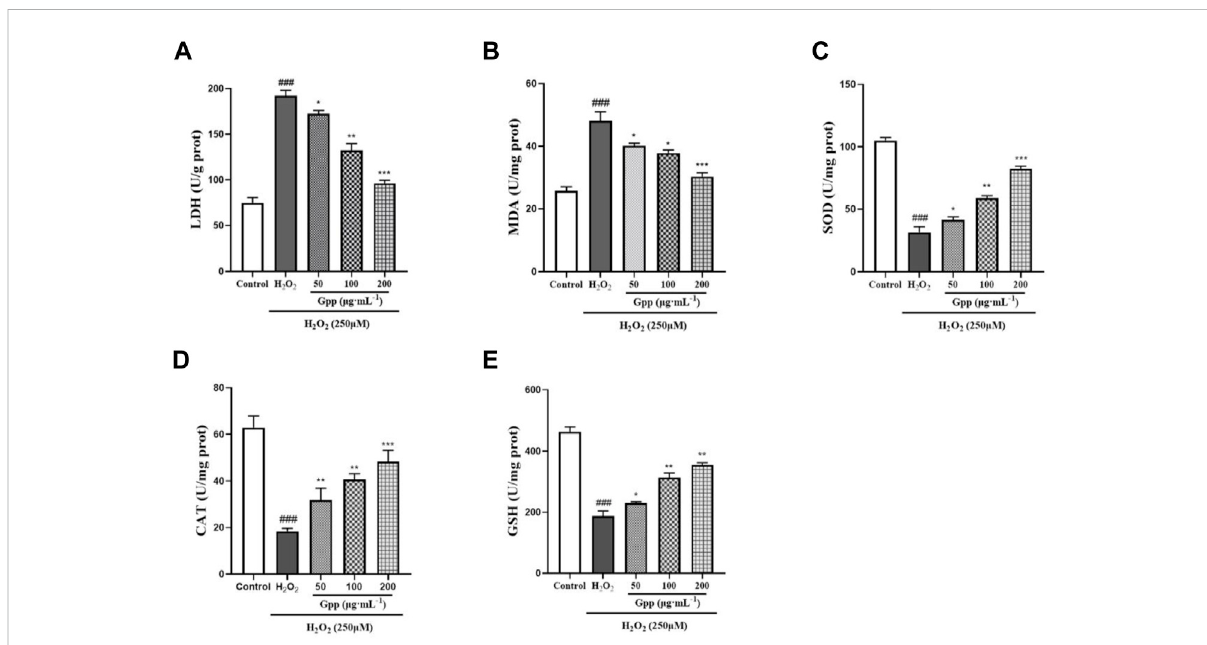
FIGURE 5 Effect of GPP pretreatment on H 2 O 2 -induced damage to LDH (A) , MDA (B) , SOD (C) , CAT (D) , and GSH-Px (E) . * p < 0.05, ** p < 0.01, *** p < 0.001, versus